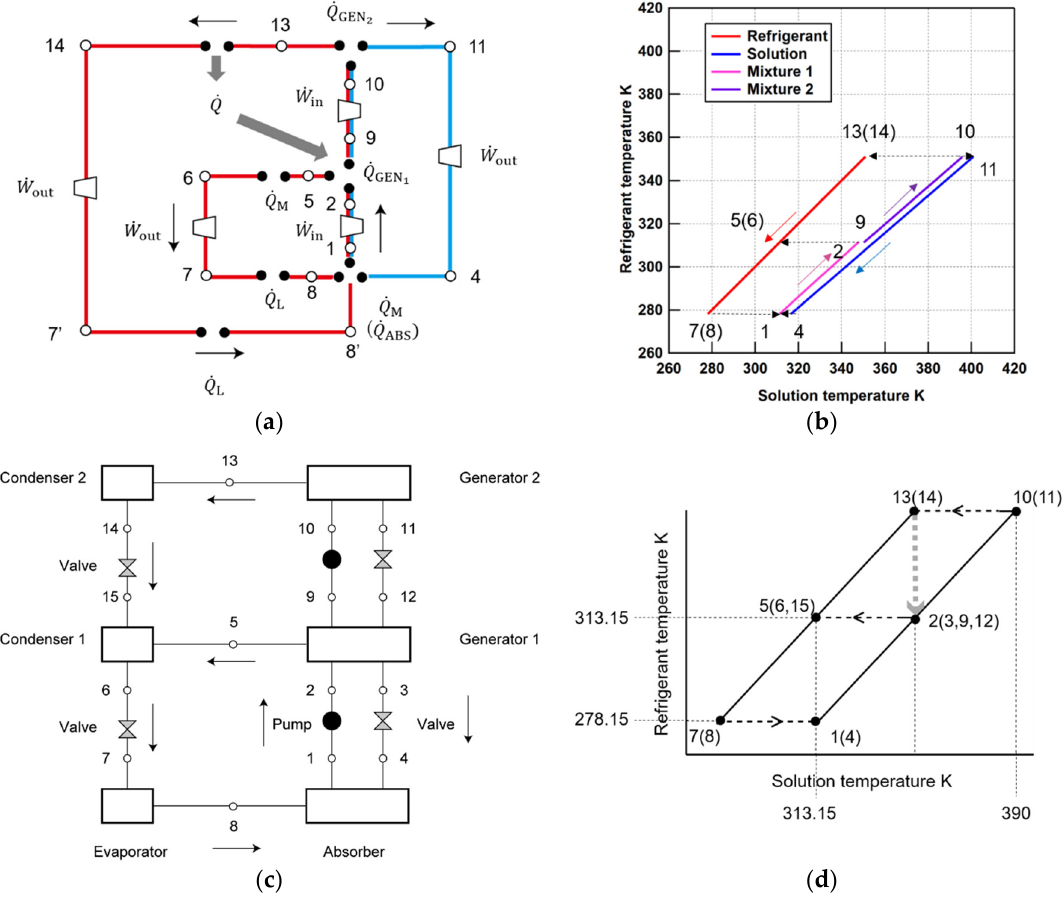
Figure 10. Optimal solution in case Y (red line—refrigerant, blue line—absorbent solution): ( a ) Basic configuration calculated; ( b ) Operating properties calculated; ( c ) Cycle configuration of an existing double-effect absorption refrigerator; ( d ) Operating properties of an existing